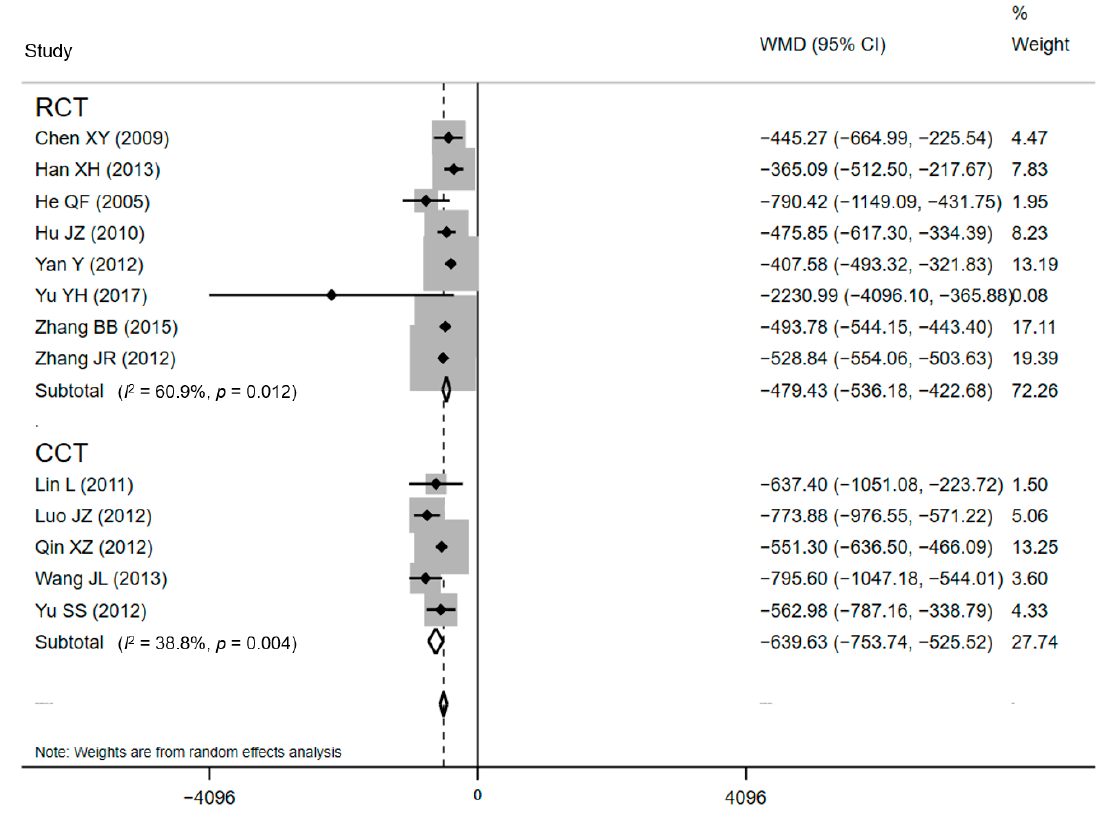
Figure 5. Forest plot of effects on DHC in different subgroups. Abbreviations: WMD, weighted mean difference; CI, confidential interval; DHC, direct hospitalization cost. Table 2. Results of subgroups analyses and tests of interaction.